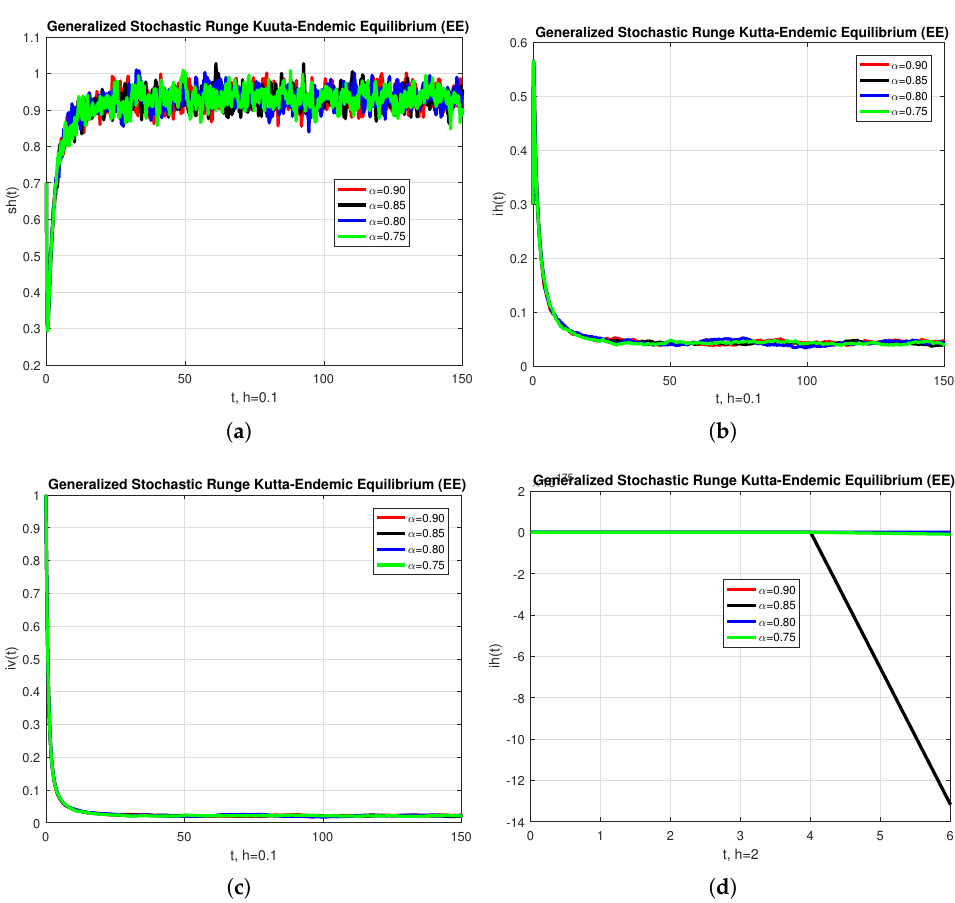
Figure 2. The graphical performance of each sub-population is presented in the ( a ) numerical solution of s h , ( b ) numerical solution of i h , ( c ) numerical solution of i v and ( d ) numerical solution of i h , with different value of α , using the generalized fractional stochastic Runge–Kutta method.